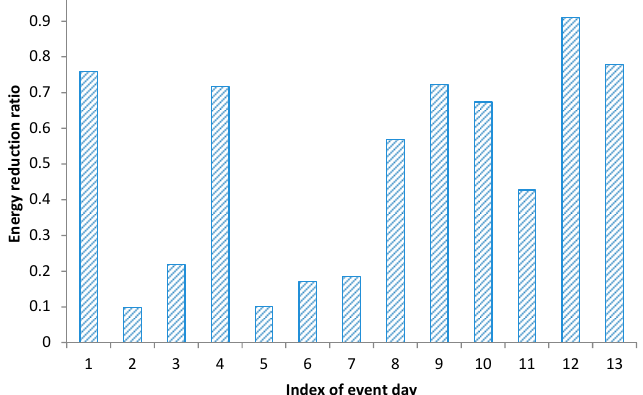
Figure 5. Distribution of the energy reduction ratio of a customer. The energy reduction is highly dependent on the decision of the site operator. In this case, the distribution is close to bimodal distribution, rather than Gaussian distribution.